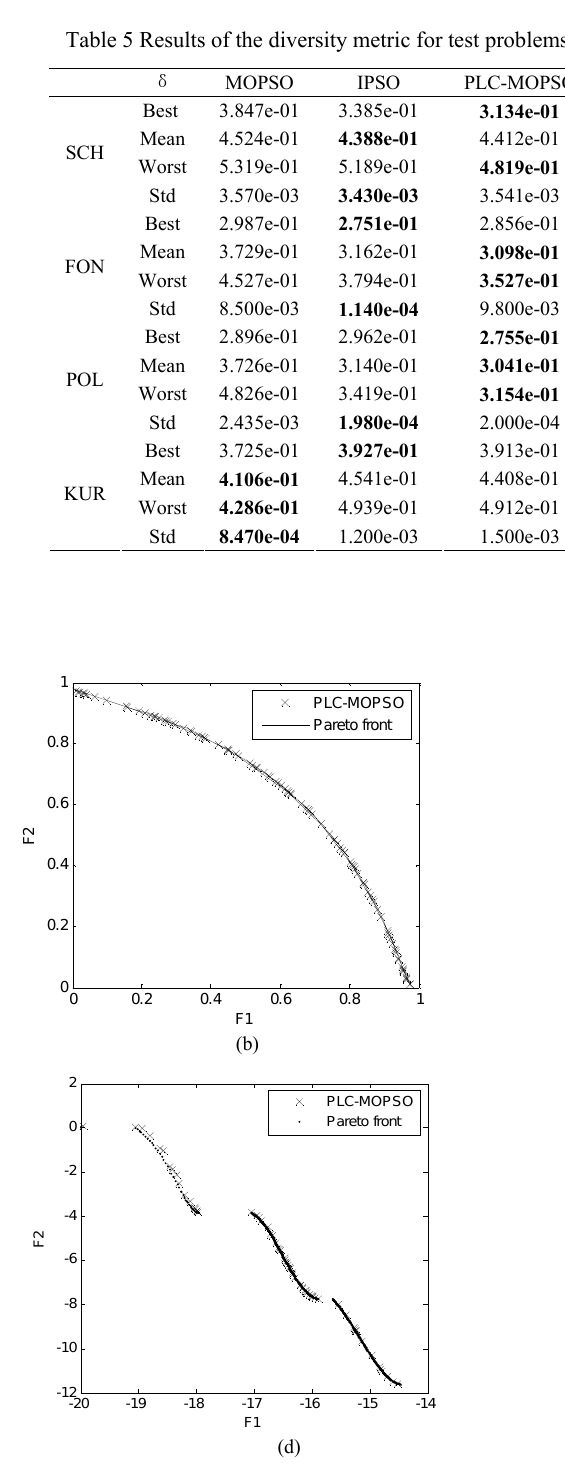
Fig. 4 Nondominated solutions with PLCPSO for four MOO problems. (a)SCH, (b)FON, (c) POL,